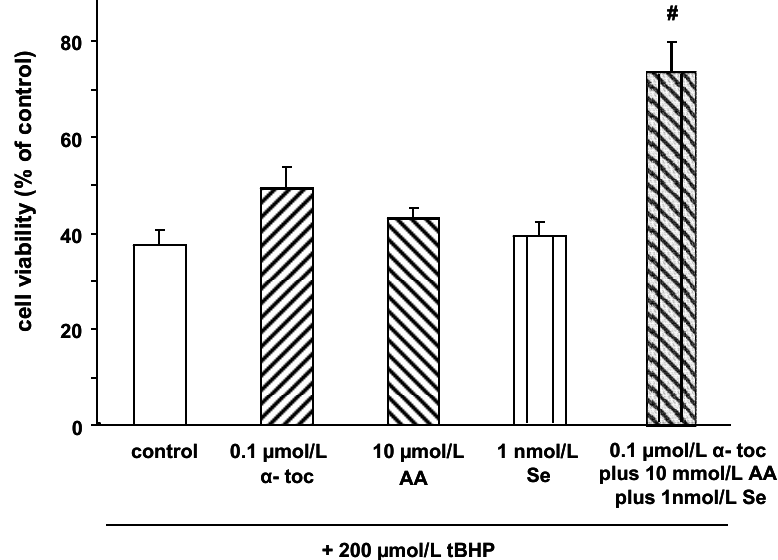
Figure 2. Effect of α -tocopherol, ascorbic acid, selenium, and their combination on cell viability in SW1353 cells after challenge with tBHP. Cells were treated with α -tocopherol (0.1 µmol/L), ascorbic acid (10 mmol/L), selenium (1 nmol/L), and a combination of all three test compounds (0.1 µmol/L α -tocopherol, 10 µmol/L ascorbic acid, and 1 nmol/L selenium) for 24 h. After 3 h of challenge with 200 µmol/L t -BHP the neutral red assay was performed. Data are means + SEM of two independent experiments performed in duplicate. # p < 0.01; compared to control.